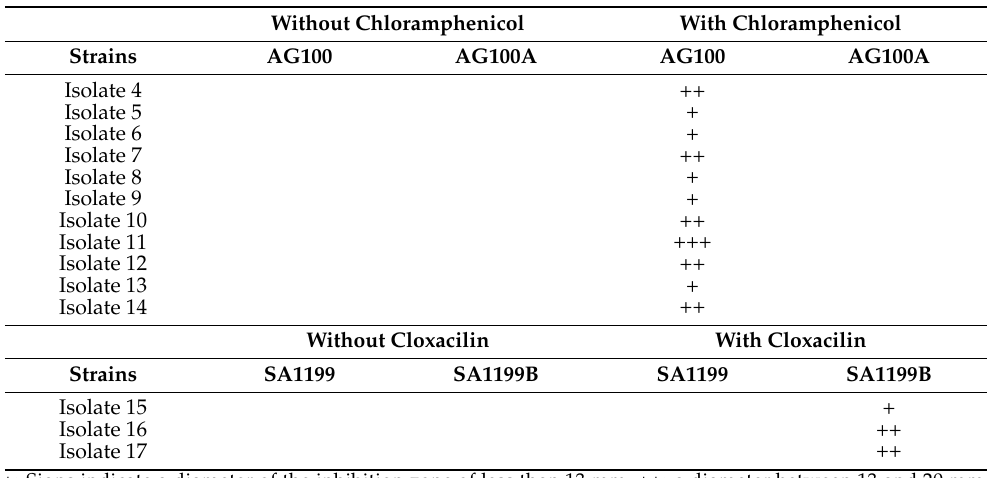
Table 3. The Actinobacteria strains with an efflux pumps inhibitory activity against E. coli and S. aureus in the absence and presence of the antibiotic using the confirmatory assay of the agar well diffusion